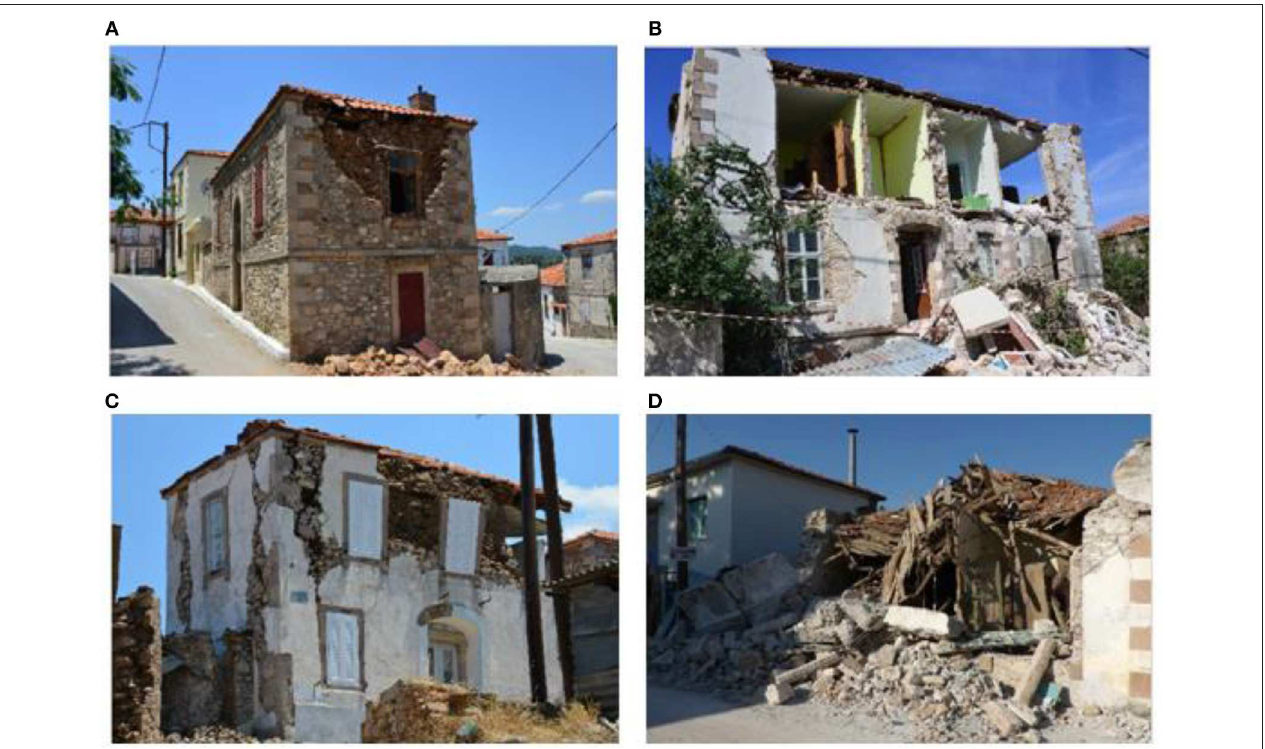
FIGURE 1 | Typical damage to unreinforced masonry buildings that underwent partial or global collapse during the 2017 Lesvos earthquake (Lekkas et al., 2017; Reproduced with the permission of the authors). (A) The masonry failed under out-of-plane bending due to lack of a rigid diaphragm at the top. (B) The longitudinal masonry walls failed under out-of-plane bending due to their poor connection to the transverse walls. (C,D) Failures attributed to poor material properties and construction